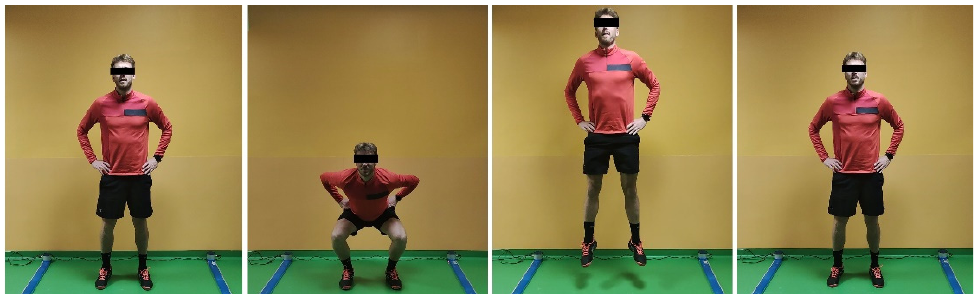
Figure 2. Bipodalic countermovement jump.